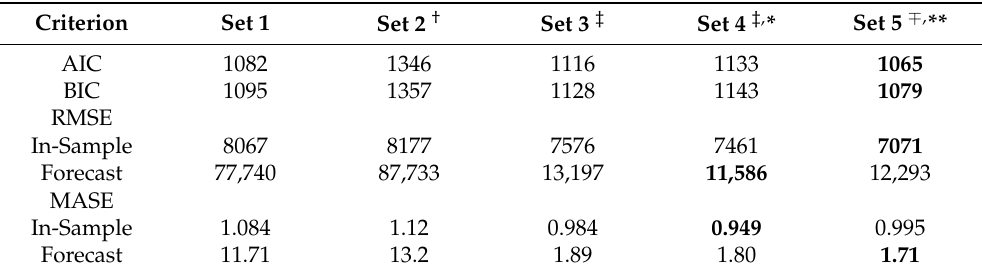
Table 2. Evaluation of different component sets for univariate UCMs. Removing the cyclic component significantly increases forecast performance (Set 3). Best results were achieved with Set 5 (fixed slope +